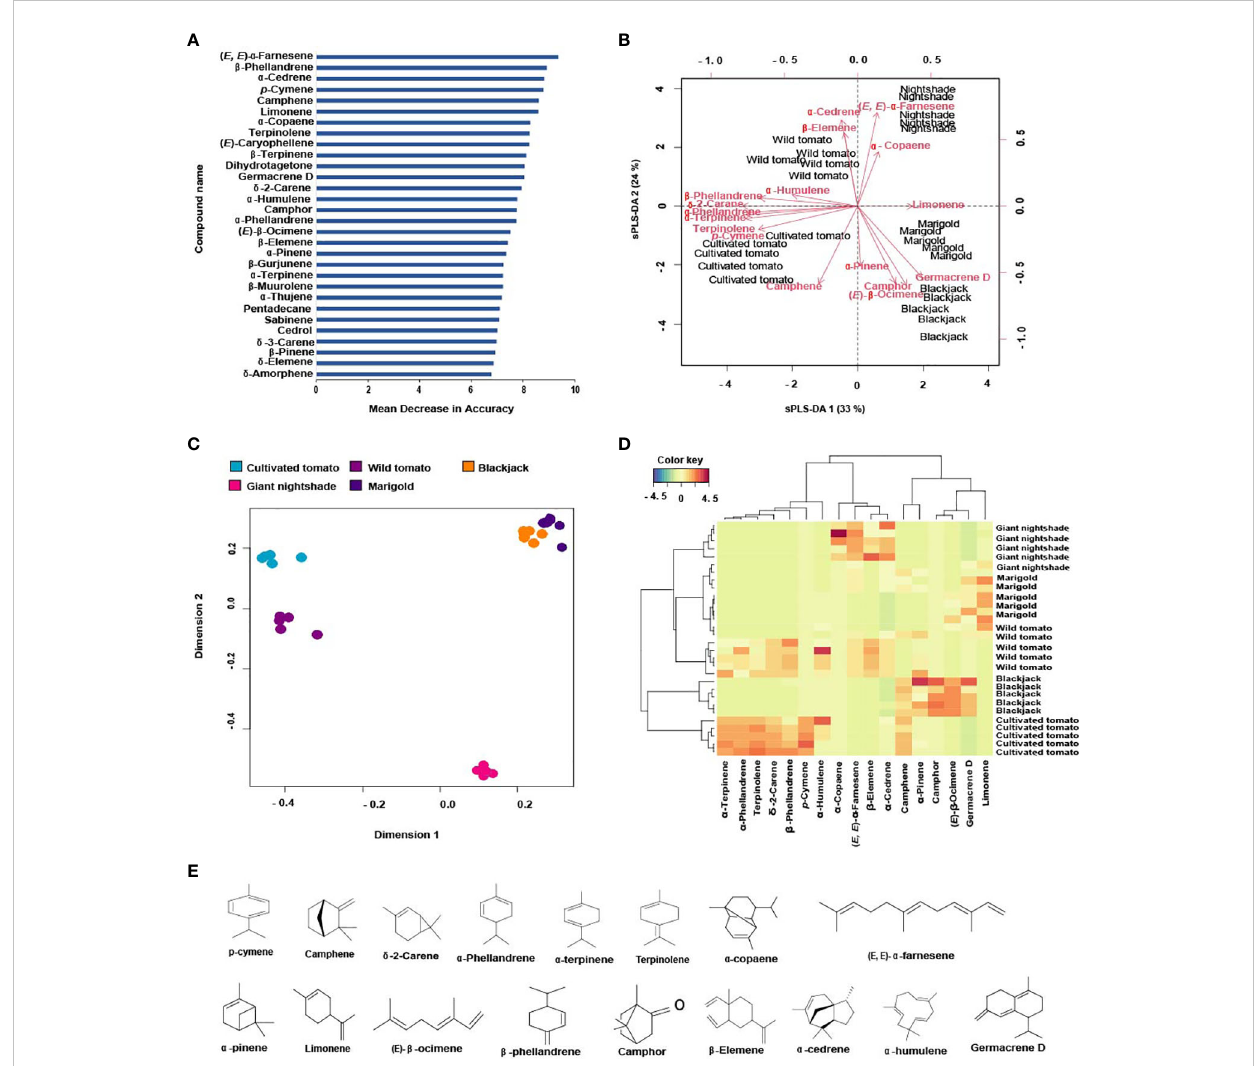
FIGURE 1 Determination of the most discriminating volatiles and their correlation with host and non-host plants of Tuta absoluta: (A) The 30 volatiles that best-distinguished host and non-host plants based on the mean decrease in accuracy of the random forest analysis, (B) Multidimensional scaling (MDS) plot showing the distribution of host and non-host plants volatile pro fi les, (C) sPLS-DA biplot showing the correlation of the top discriminating volatiles (R2X = 0.57, R2Y = 0.74, Q2 = 0.58), (D) Clustering heatmap showing the abundance of the top discriminating volatiles across replicates of the host and non-host plants, and (E) Chemical structures of the top discriminating